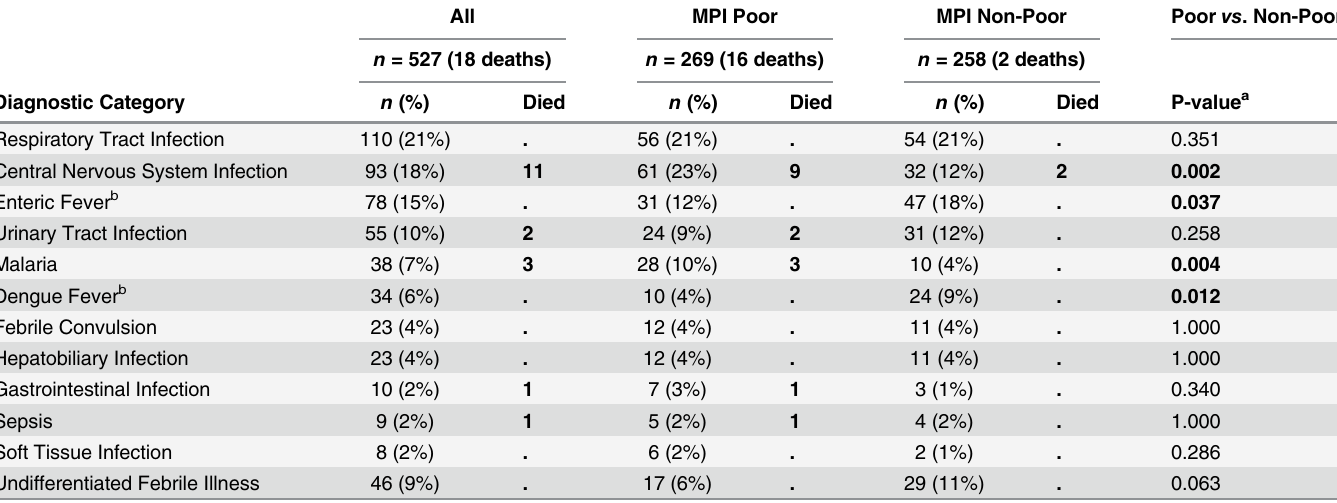
Table 3. Summary of clinical diagnoses and deaths, disaggregated by age and MPI groups.